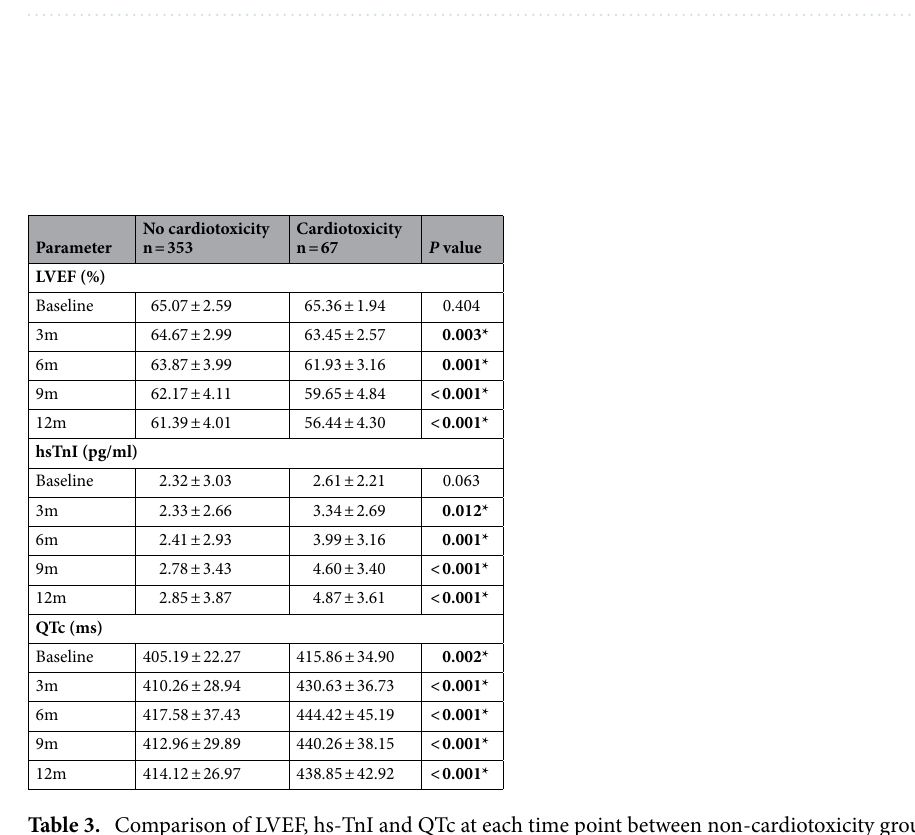
Figure 2. Multivariate analysis of cardiotoxicity associated with targeted therapy ( OR odds ratio, CAD coronary artery disease; * P < 0.05).